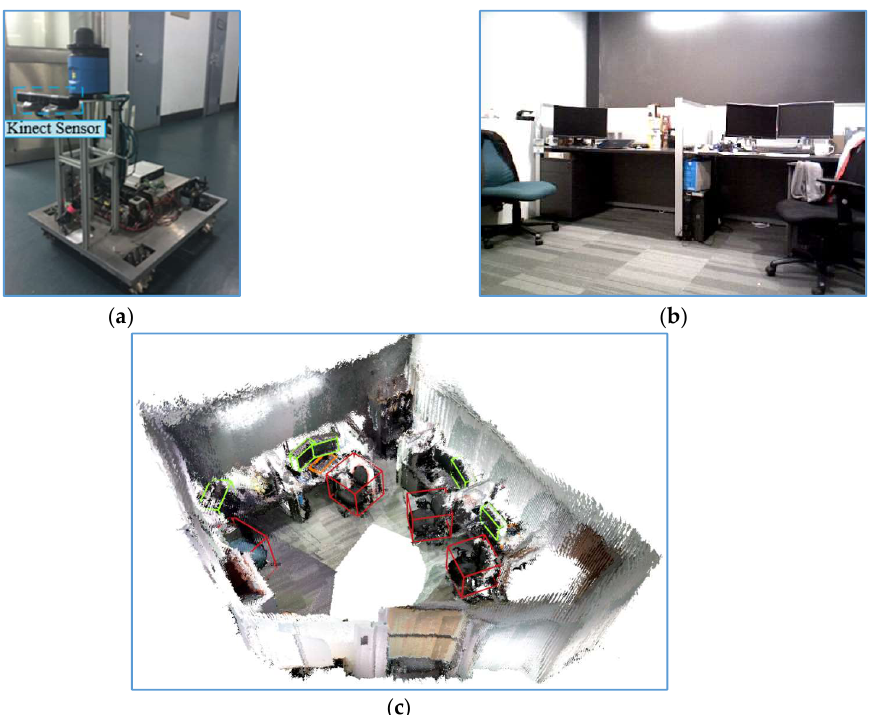
Figure 10. The real environmental experiment using a robot: ( a ) the robot with a Kinect V1 sensor; ( b ) the image of real indoor environment; and ( c ) the 3D object detection results with point cloud.